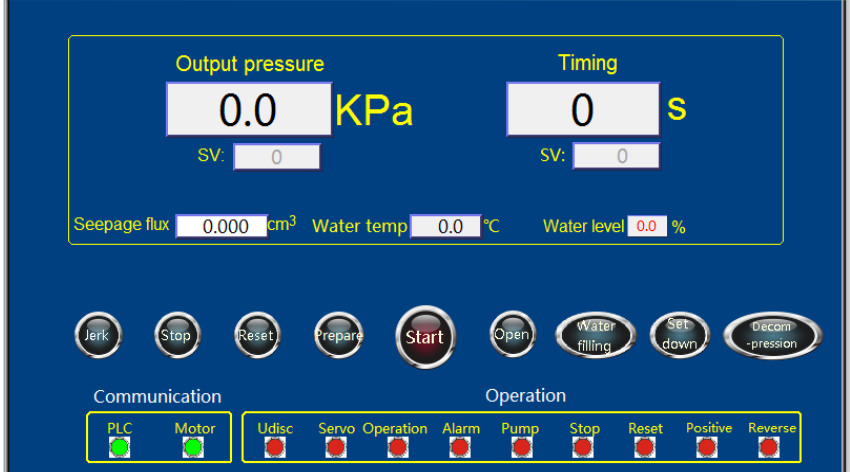
Figure 6. Human – computer interface of the seepage apparatus. Figure 6. Human–computer interface of the seepage